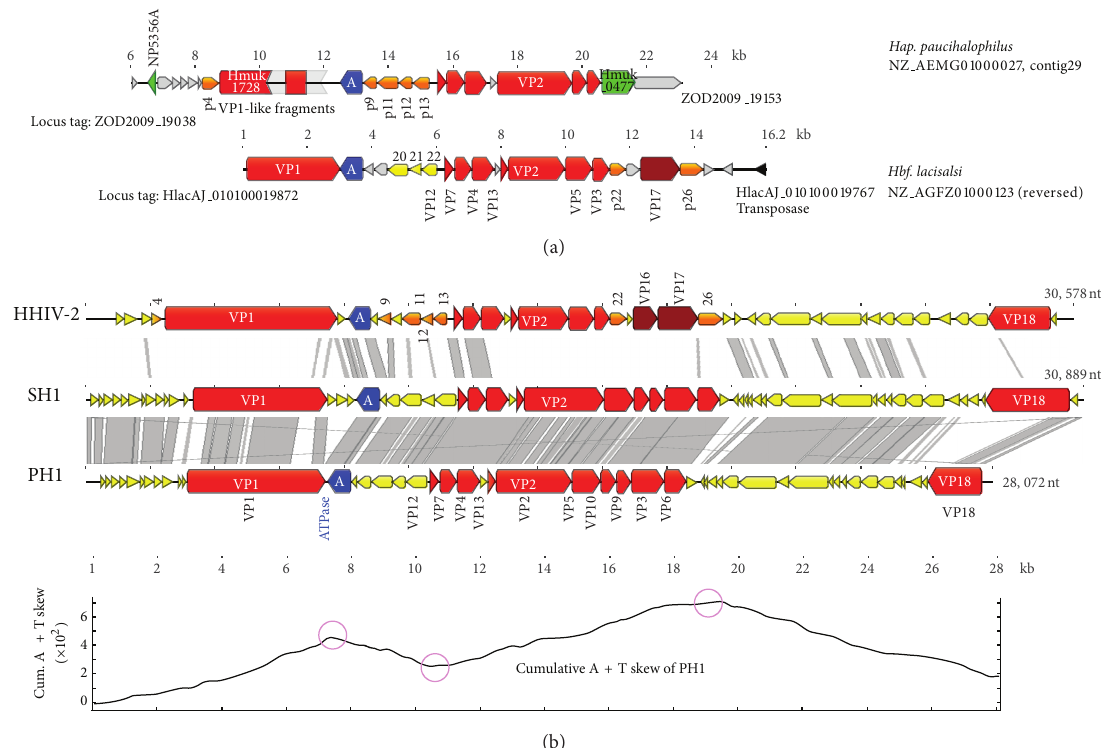
Figure 6: Genome alignments of haloviruses PH1, SH1, and HHIV-2, along with two related genomic loci. (a) Genomic loci of Hap. paucihalophilus and Hbf. lacisalsi that contain genes related to halosphaeroviruses SH1, PH1, and HHIV-2. The names and GenBank accessions for these contigs are given on the far right, and ORFs are coloured and labeled to indicate the relationships of these ORFs to those of the viruses below. The locus tag numbers for thefirstand last ORFs shown in each locus are given nearby their respective ORFs. In addition, grey coloured ORFs represent sequences that do not match any of the haloviruses, and green coloured ORFs represent protein sequences that are closely related to ORFs found within or very close to previously described virus/plasmid loci, so called ViPREs [20]. The scale bars shown above each contig show the position of the described region within the respective contig. (b) The three virus genomes are labeled at the left, with scale markers below (in kb) and the total length indicated at the far right. At the bottom is a cumulative AT-skew plot of the PH1 genome (http://molbiol-tools.ca/Jie Zheng/), with inflection points circled. The grey shaded bands between the genome diagrams indicate significant nucleotidesimilarity(usingACT[63]).AnnotatedORFsarerepresentedbyarrows,withcoloursindicatingstructuralproteins(redorbrown), nonstructural proteins (yellow or orange) or the packaging ATPase (blue). The names of structural protein ORFs are indicated either within the arrow (e.g., VP1) or in text nearby. The numbered, orange coloured ORFs of HHIV-2 are homologous to ORFs found in the genomic loci (probably proviruses or provirus remnants) pictured in